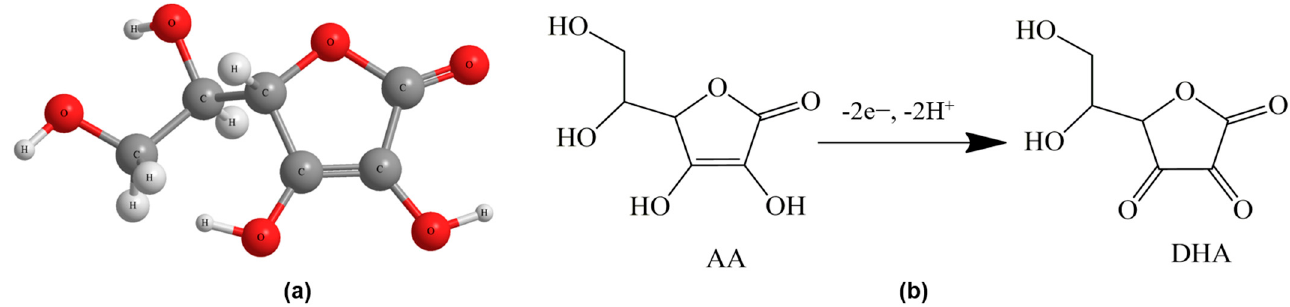
Figure 2. ( a ) Chemical structure of ascorbic acid and ( b ) ascorbic acid oxidation to produce dehy- droascorbic acid.